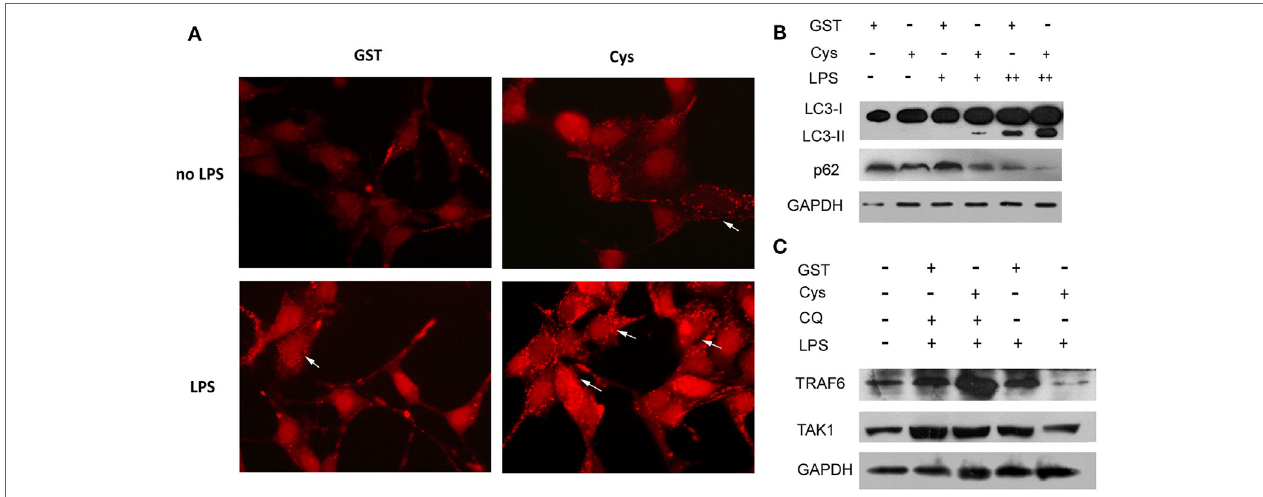
FigUre 5 | DsCystatin enhances LPS-induced autophagy, thereby leads to the degradation of TRAF6 via an autophagy-dependent manner. (a) DsCystatin enhances LPS-induced autophagy in TLR4-293 cells. The autophagosome formed by accumulation of mCherry-LC3 was indicated by arrows. (B) DsCystatin enhances LPS-induced autophagy in TLR4-293 cells as indicated by Western blotting analysis of autophagy markers LC3-II and p62. (c) The degradation of TRAF6 induced by DsCystatin is blocked in the presence of autophagy inhibitor chloroquine (CQ) [LPS + (1 µg/ml), ++ (5 µg/ml)]. The representative results from at least three independent experiments are